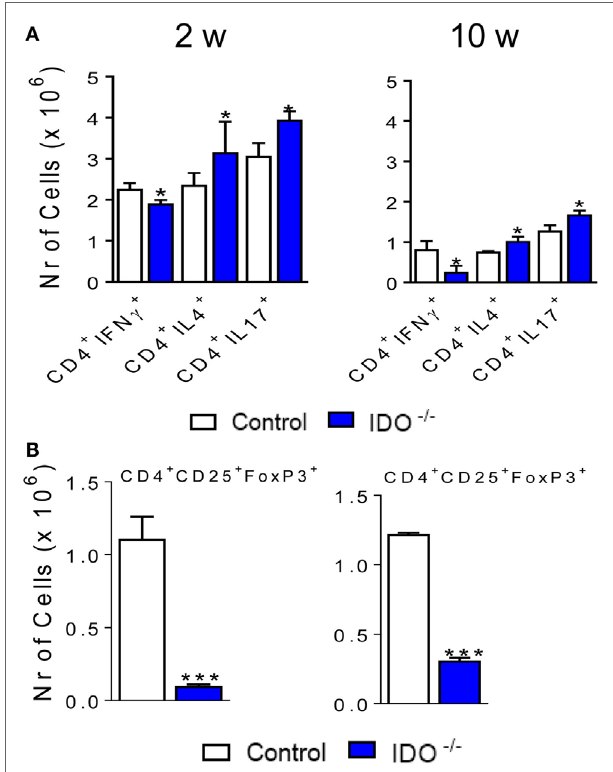
FigUre 9 | The absence of indoleamine 2,3 dioxygenase-1 (IDO1) increases the number of pulmonary Th17 but reduces the presence of Th1 and regulatory T (Treg) cells. The phenotypic analysis of lung infiltrating lymphocytes from wild-type and IDO1 − / − mice was performed at 2 and 10 weeks of Paracoccidioides brasiliensis infection. The lung cells were obtained as described in Section “Materials and Methods” and labeled with antibodies conjugated to different fluorochromes. The lung infiltrating leukocytes were gated by FSC/SSC analysis. (a) The cells were gated for CD4 + and then for intracellular expression of IL-4, IL-17, IL-22, or IFN- γ . (B) For Treg cells characterization, the FoxP3 + cells were counted on CD4 + CD25 + double- positive cells. For gate strategy, see Figure S3 in Supplementary Material. One hundred thousand cells were acquired on FACS CANTO II and subsequently analyzed by FlowJo software. Data are expressed as means ± SEM and are representative of three independent experiments using five mice of each mouse strain per group (* p < 0.05 and *** p <